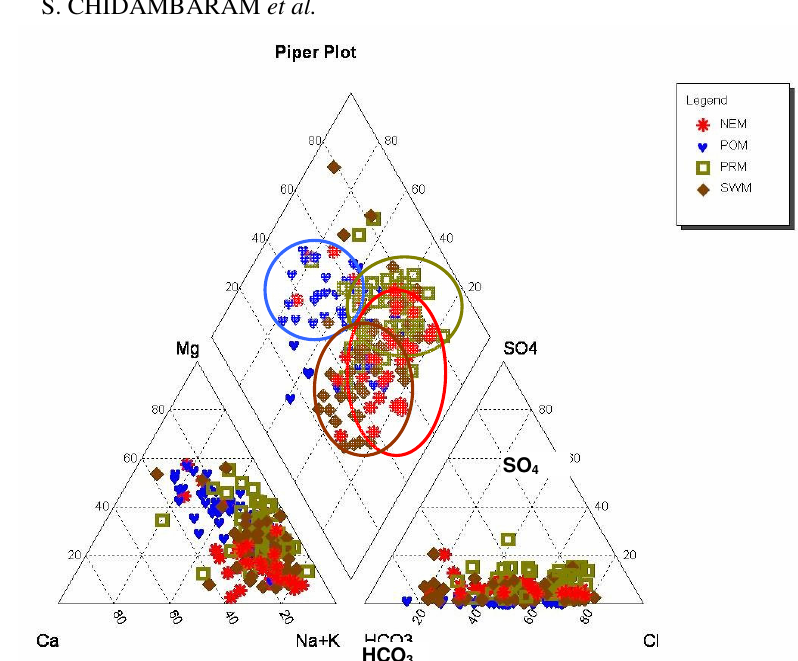
Figure 3 . Piper tri-linear diagram for hydrogeochemical